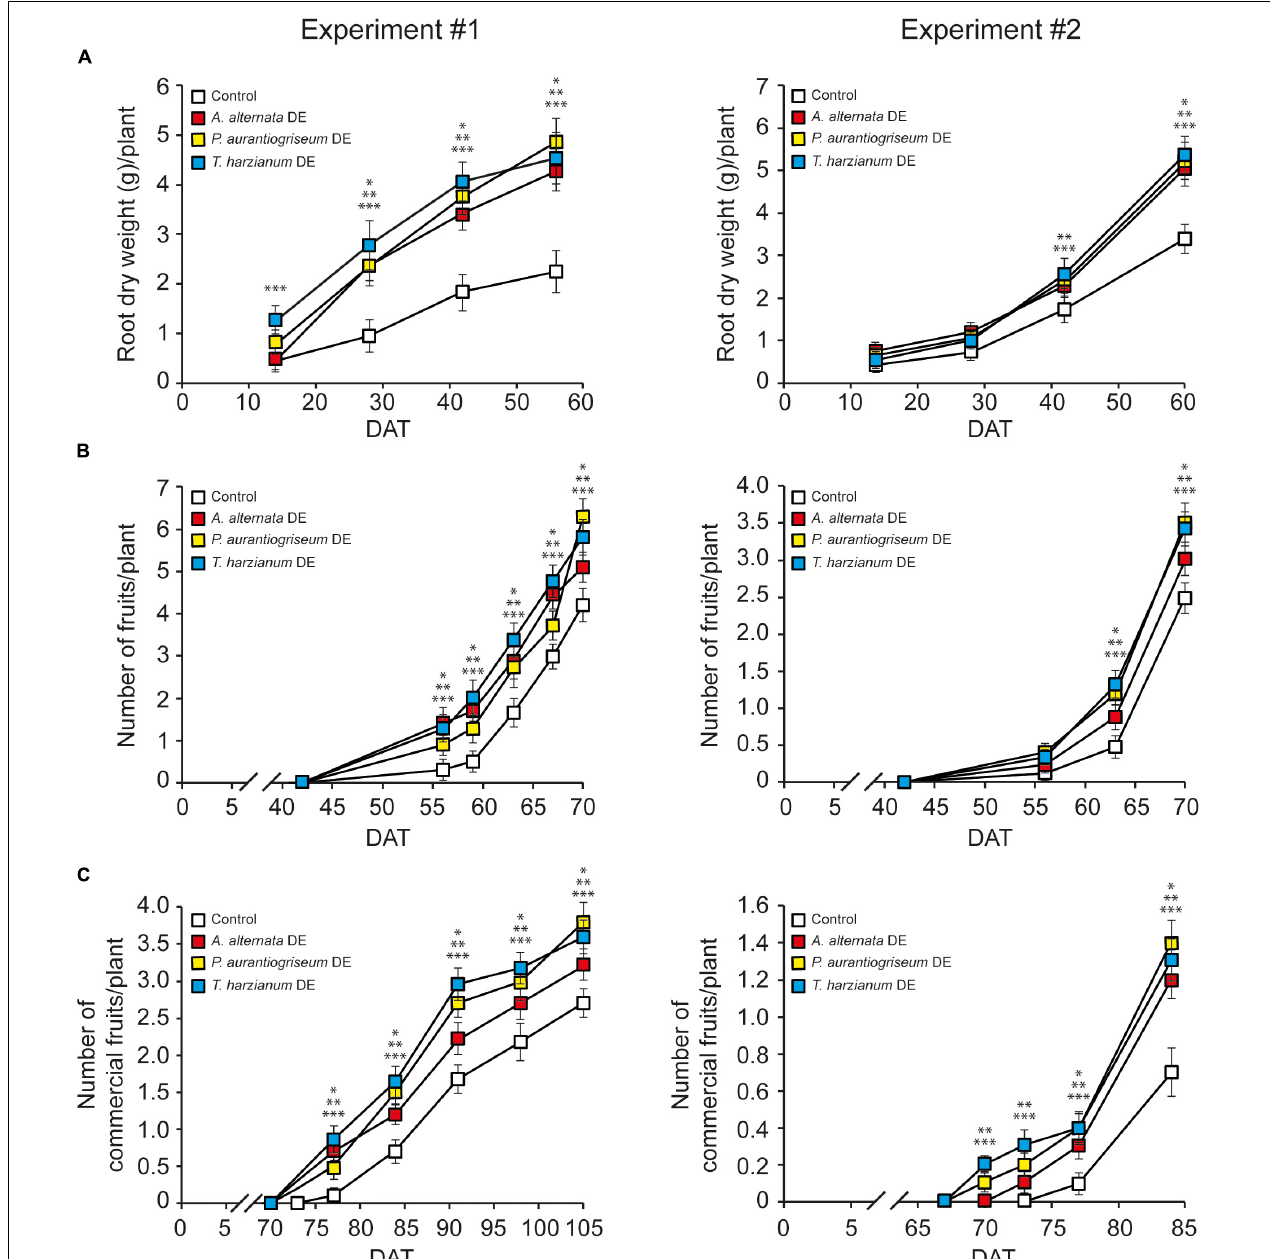
FIGURE 2 | Soil application of fungal DEs stimulates root growth and induces early fruit development in pepper plants. Data over the time for root dry weight (A) and number of total fruits (B) and commercial fruits (C) per pepper plant (cv. Sweet Italian) after the first application of A. alternata, P. aurantiogriseum , and T. harzianum DEs on soil. Plants were grown under greenhouse conditions. Values were obtained from two independent experiments and represent the mean ± SD of 12 different plants. Asterisks indicate significant differences between DE-treated plants and plants irrigated with DE control according to a Student’s t -test (* P < 0.05, +